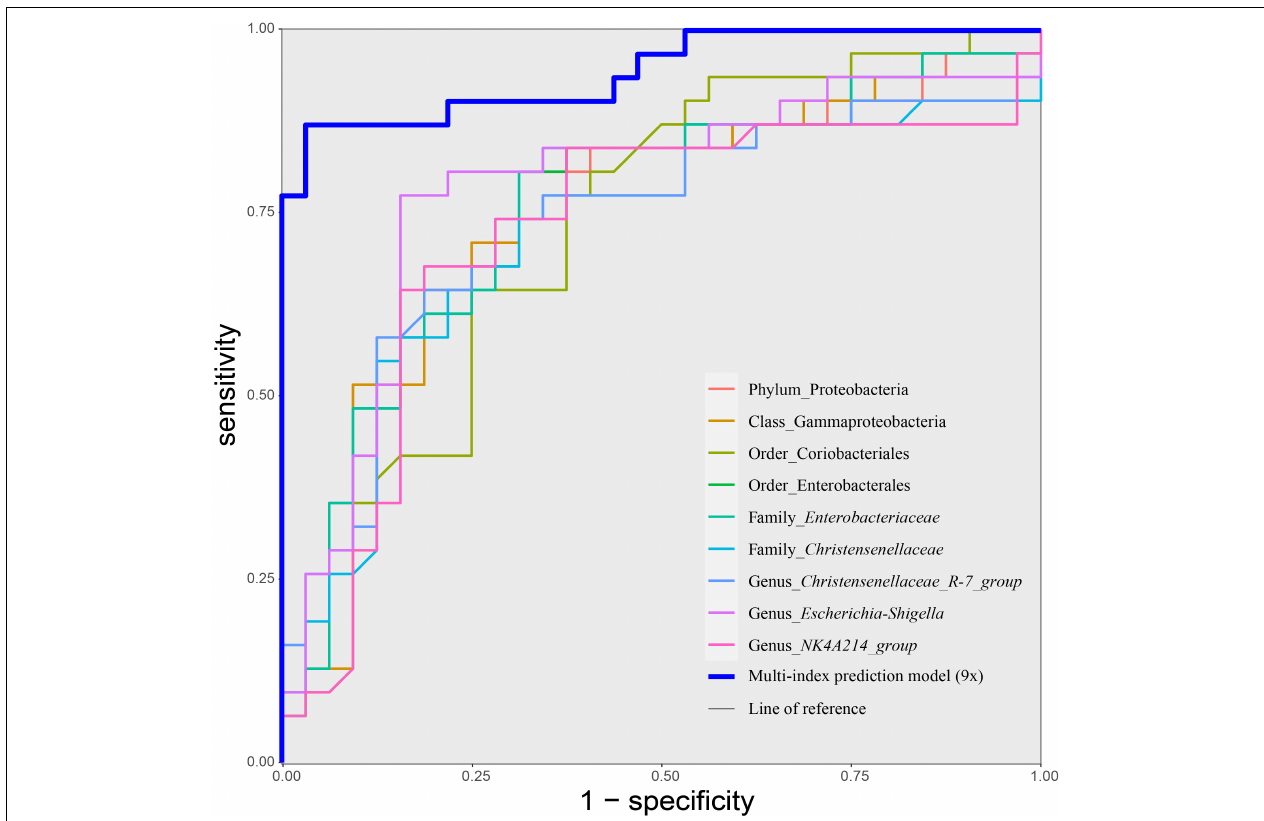
FIGURE 6 | Receiver operating characteristic (ROC) curves of taxa-based single index and the multiple joint model (9 × ) for discriminating cognitive impairment of hypertension patients. Discriminatory capacity was analyzed by calculating the area under the ROC curve using logistic regression. MCI, hypertension patients with cognitive impairment; NMCI, hypertension patients without cognitive impairment; Control, health control